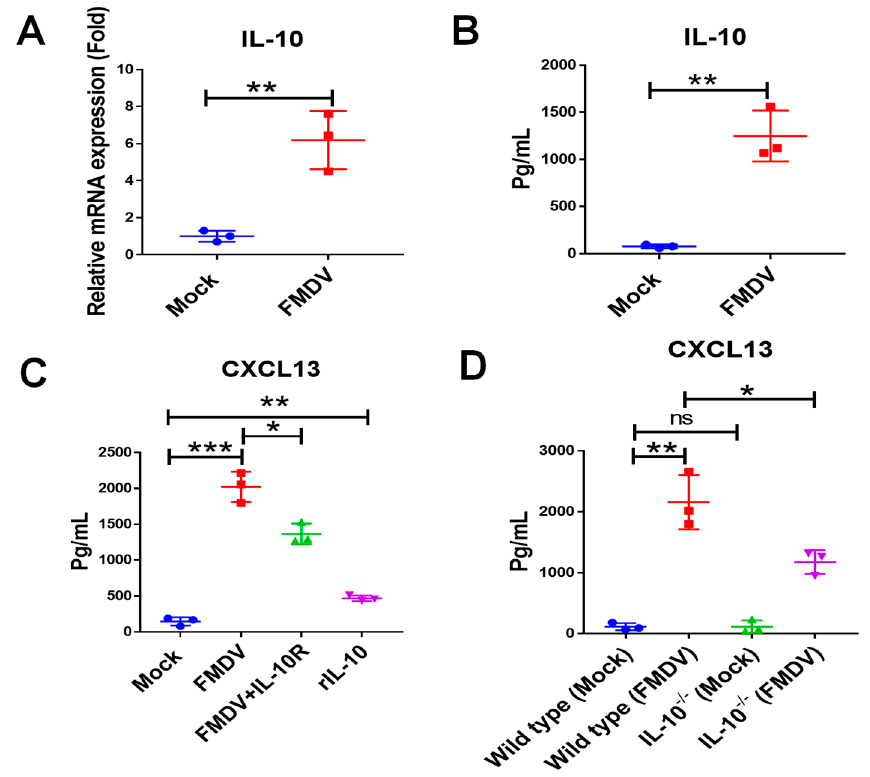
Figure 4. IL-10 controlled CXCL13 expression in BMDMs infected with FMDV. The mRNA ( A ) and protein ( B ) expression of IL-10 in BMDMs infected with FMDV at 24 hpi were measured by RT- qPCR and ELISA, respectively. The CXCL13 concentrations of the supernatant from BMDMs, BMDMs infected with FMDV, BMDMs treated by anti-IL-10R antibody and infected with FMDV, and BMDMs stimulated with rIL-10 at 20 ng/mL ( C ) and from BMDMs, BMDMs infected with FMDV, IL-10 -/- BMDMs, and IL-10 -/- BMDMs infected with FMDV at 24 hpi ( D ) were measured by ELISA. Significance was detected using unpaired t test. *, p ≤ 0.05; **, p ≤ 0.01; ***, p ≤ 0.001. While ns indicates a non-statistically significant difference ( p > 0.05).